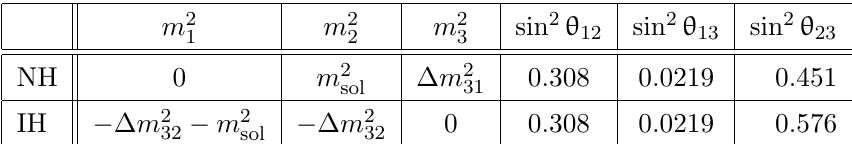
Table 1 . Recently updated best (cid:12)t values for the active neutrino masses m a and mixings (cid:18) ab in case of NH in the top row and IH in the bottom row taken from ref. [111]. The smaller measured mass di(cid:11)erence (solar mass di(cid:11)erence) is for both hierarchies given by m 2 = m 2 (cid:0) m 2 = 7 : 49 (cid:2) 10 (cid:0) 5 eV 2 , 2 1 sol while the larger mass di(cid:11)erences are given by (cid:1) m 2 = m 2 (cid:0) m 2 = 2 : 477 (cid:2) 10 (cid:0) 3 eV 2 for NH and 31 3 1 (cid:1) m 2 = m 2 (cid:0) m 2 = (cid:0) 2 : 465 (cid:2) 10 (cid:0) 3 eV 2 < 0 for IH. The n s = 2 (cid:13)avour case requires lightest 32 3 2 neutrino to be massless ( m 1 = 0 for NH and m 3 = 0 for IH). The atmospheric mass di(cid:11)erence m 2 is often referred to as the absolute value j m 2 (cid:0) m 2 j . Thus, n s = 2 directly sets m 2 = m 2 atm atm 3 1 3 for NH and m 2 = m 2 = m 2 + O ( m 2 =m 2 ) for IH. Even though these values for m 2 slightly atm atm atm 1 2 sol